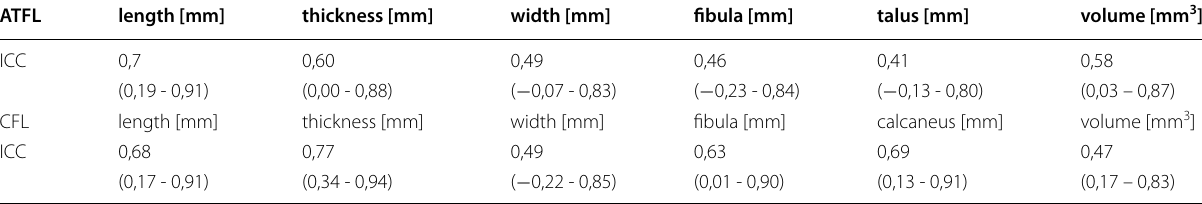
ATFL the anterior talofibular ligament, CFL the calcaneofibular ligament, ICC intra-class correlation coefficient